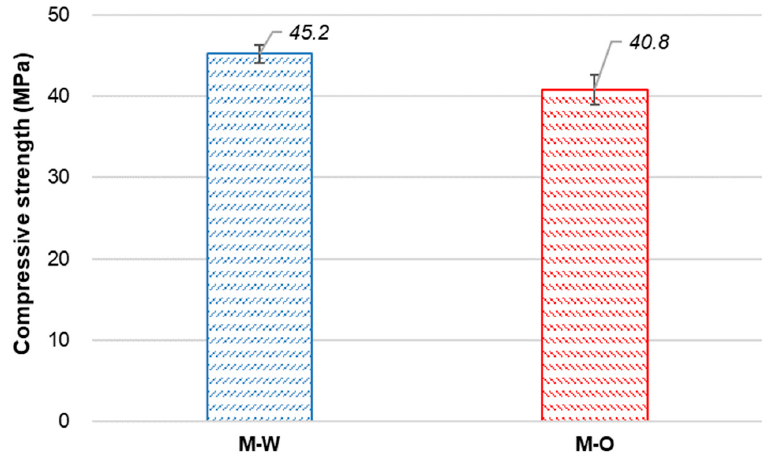
Figure 3. Compressive strength of SHCC.